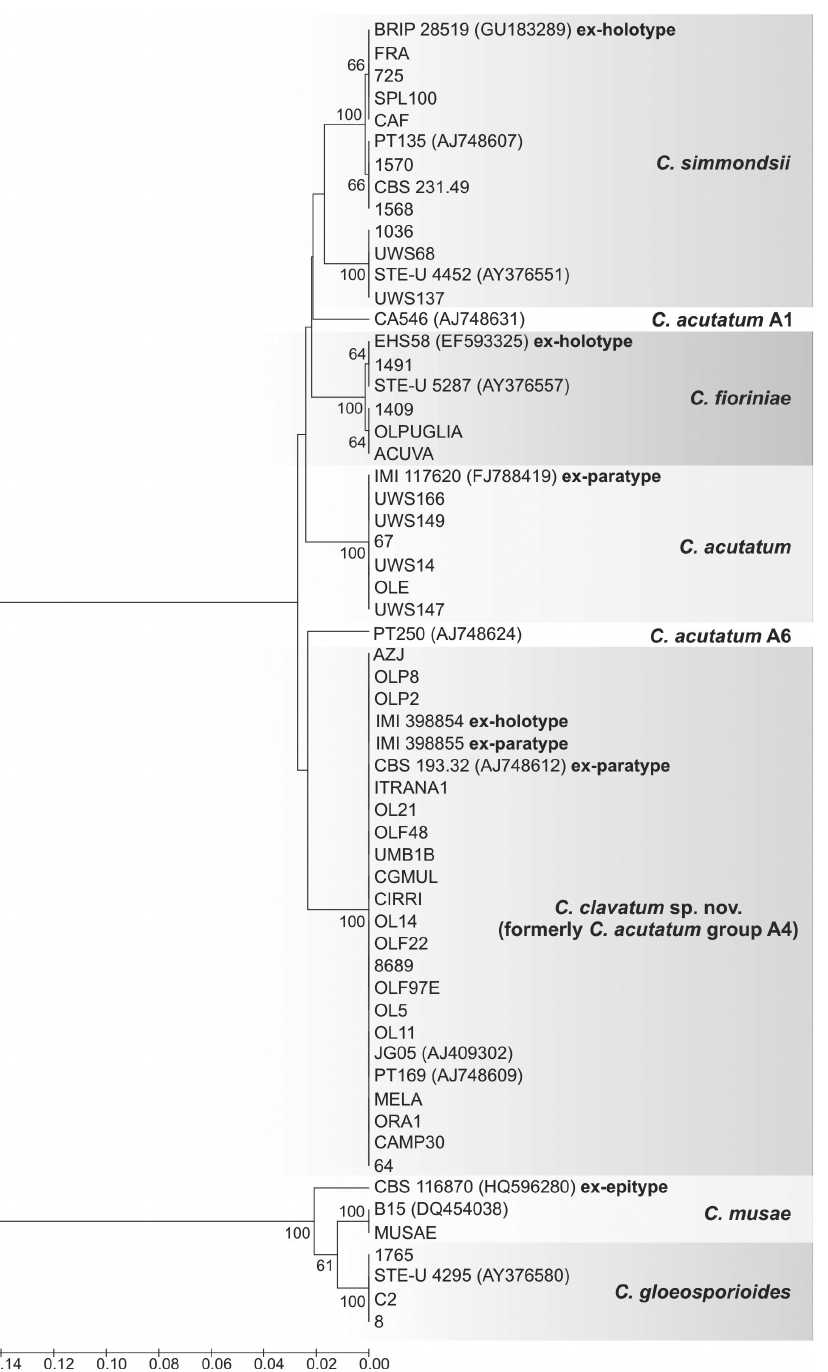
Figure 3. UPGMA phylogram of Colletotrichum inferred from partial -tubulin-2 gene DNA sequences, showing the position of C. clavatum sp. nov. in relation to other known Colletotrichum species and genetic groups of C. acutatum . Bootstrap interior-branch values (1,000 replicates) ≥ 50% are displayed between the nodes. The GenBank accession numbers of the reference sequences are in brackets preceded by the corresponding isolate codes. The scale bar indi- cates a 0.001 U of genetic distance from Kimura’s two-parameter